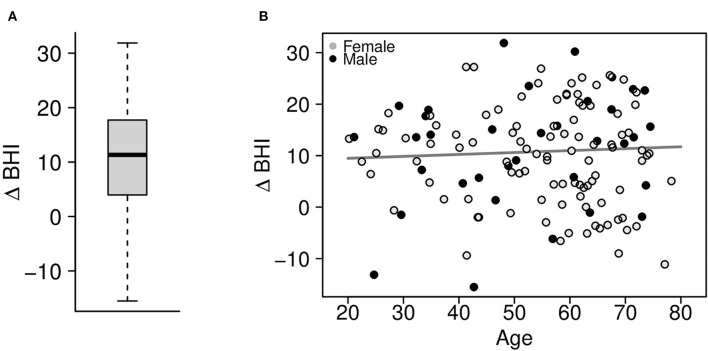
(A) Change in the preliminary BrainHealth Index after 3 months with a mean gain of 10.3 units. (B) Regression of the change in the BrainHealth Index on age by gender (shown in gray scale) shows that gains do not depend on either of these attributes.